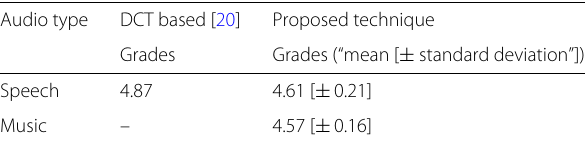
Table 2 Subjective listening test